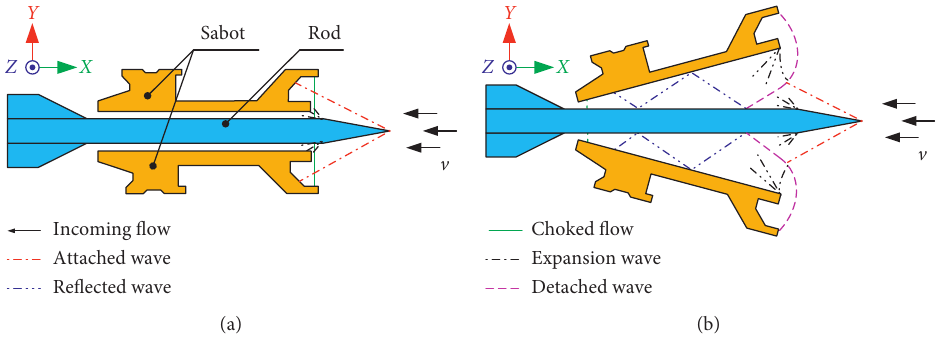
Figure 2: Schematic diagram of the SDP. (a) Initial status of sabot separation. (b) Aerodynamic interference